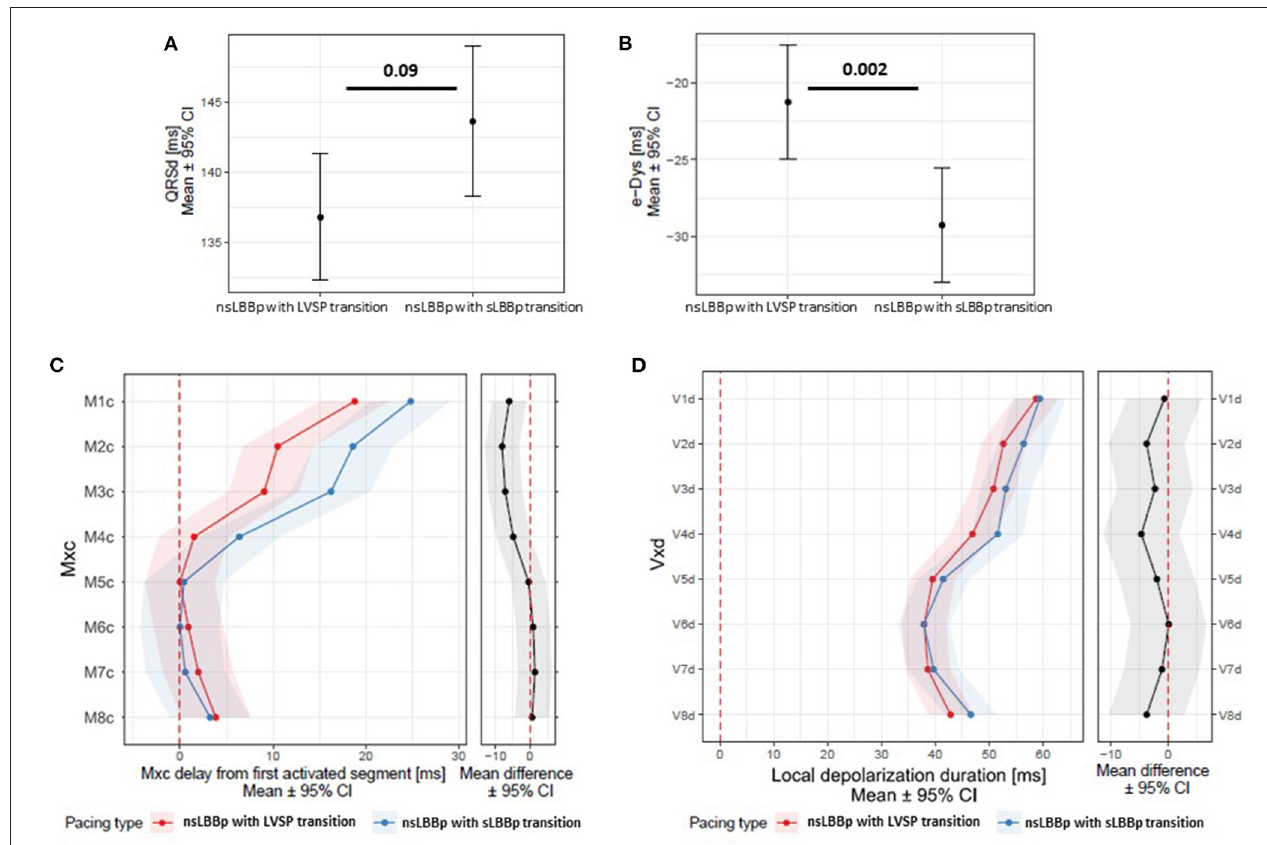
FIGURE 6 | (A) QRSd, e-DYS (B) , local activation times M1c-8c (first activated segment was placed at 0ms) (C) and in (D) local depolarization durations (Vd in V1–V8) between nsLBBp with a transition to LVSP and nsLBBp with a transition to sLBBp while decreasing the pacing output.